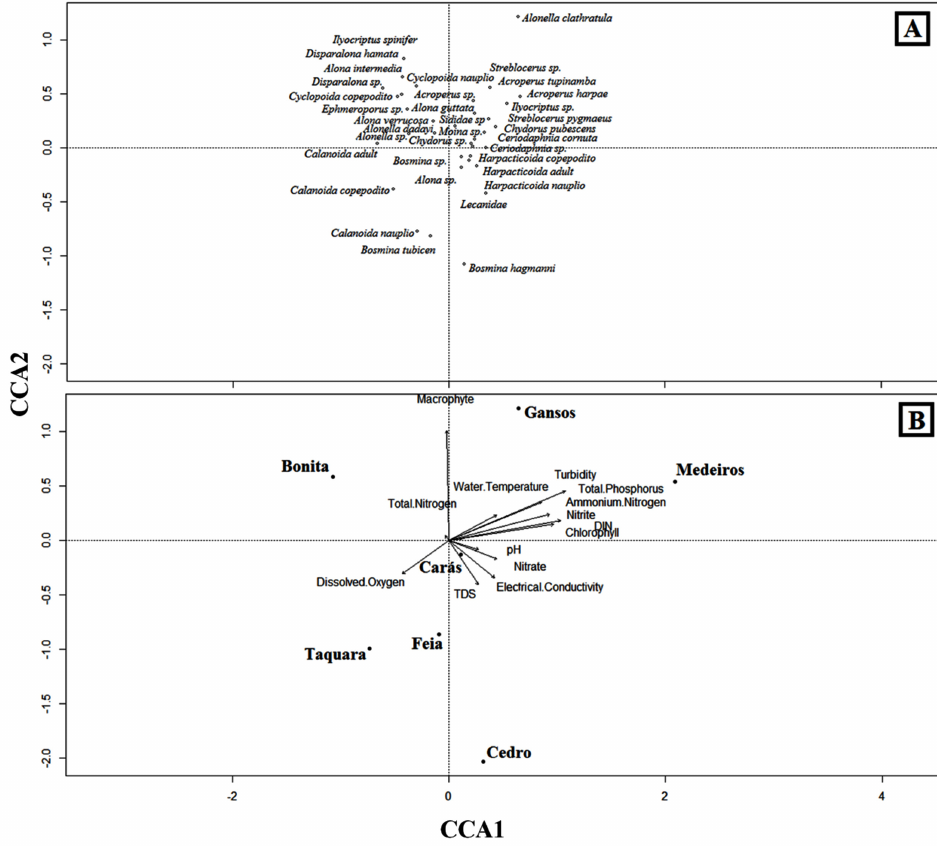
Figure 4. Canonical correspondence analysis of zooplankton community (A) and abiotic variables (B) in the seven sampling points (shallow